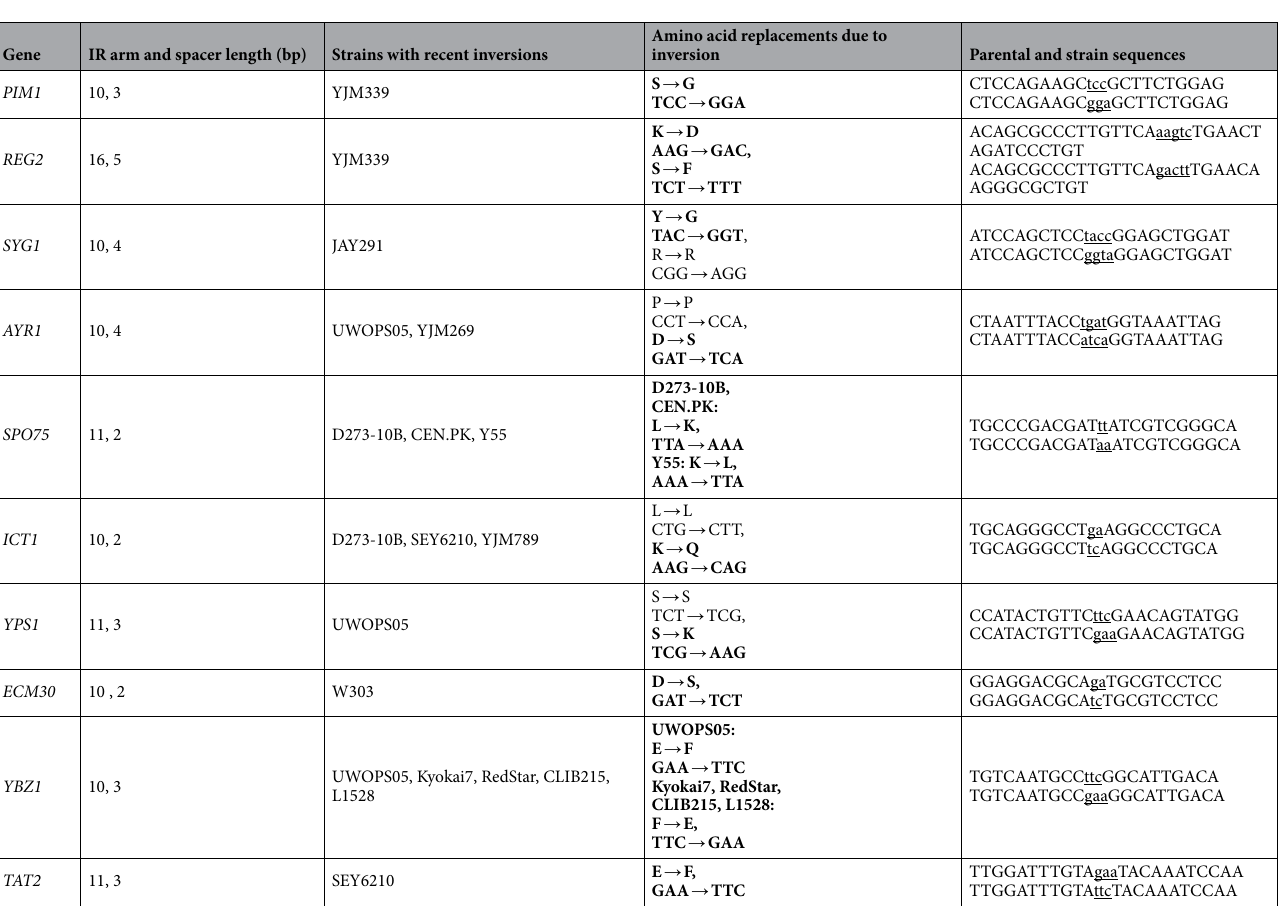
Table 2. Genes with inverted repeats and spacer inversion. Nonsynonymous substitutions are shown in bold; the spacer are underlined. UWOPS05 is a short for